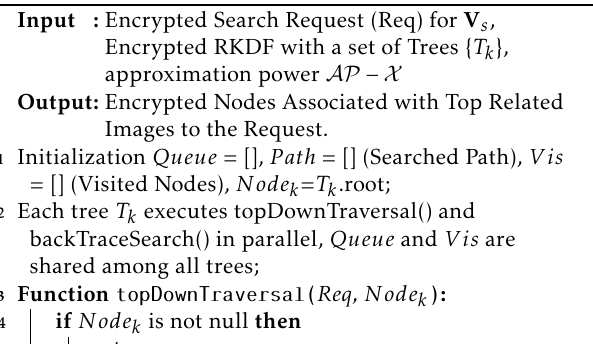
Algorithm 1: Privacy-preserving RKDF